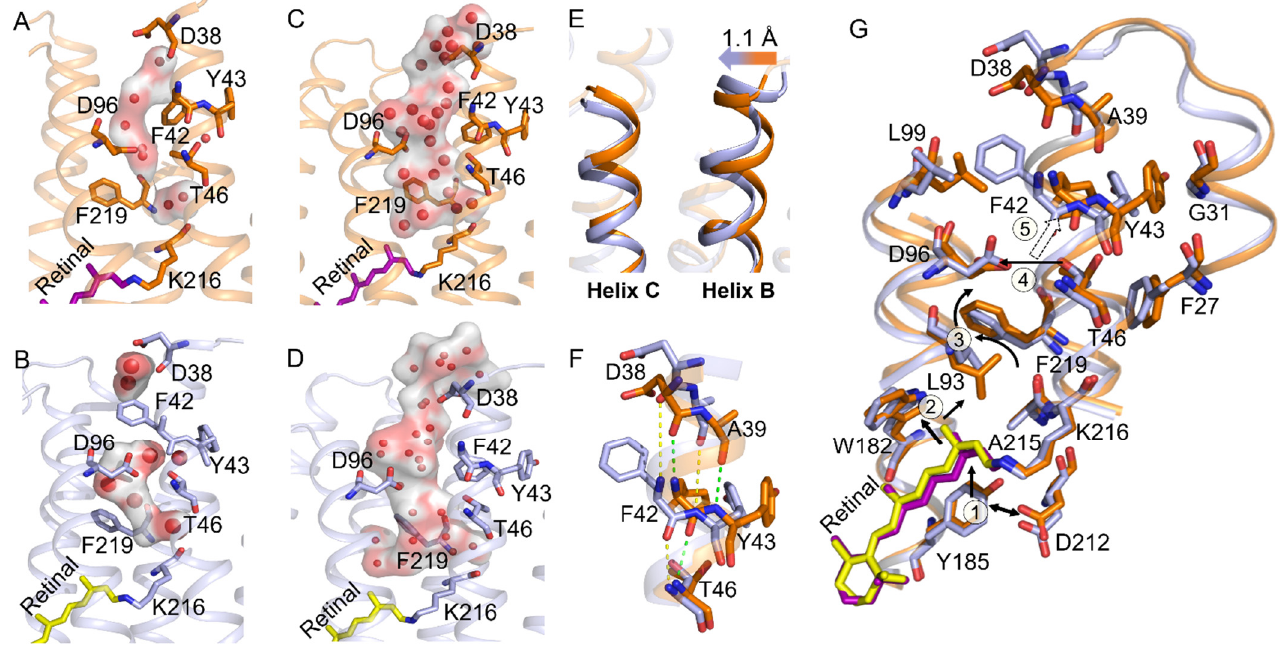
Figure 6. Detailed conformation changes in the cytoplasmic side in M 2 ’ and N states caused by the Y185F mutation. ( A – D ) Schematic diagrams of the residues and water-chain from the cytoplasmic surface to Schiff base in WT-M 2 ’, Y185F-M 2 ’, WT-bR N , and Y185F-bR N , respectively. ( E ) Superimposed conformation of helices B and C in WT-M 2 ’ and Y185F-M 2 ’. ( F ) Disrupted backbone H-bond pattern around F42 of helix B in Y185F. ( G ) The 5-step sequential conformational changes from SB to F42 by Y185F mutant in M 2 ’ state. Color codings are the same as Figure 2E, and the red spheres and transparent surface indicate the water chain.